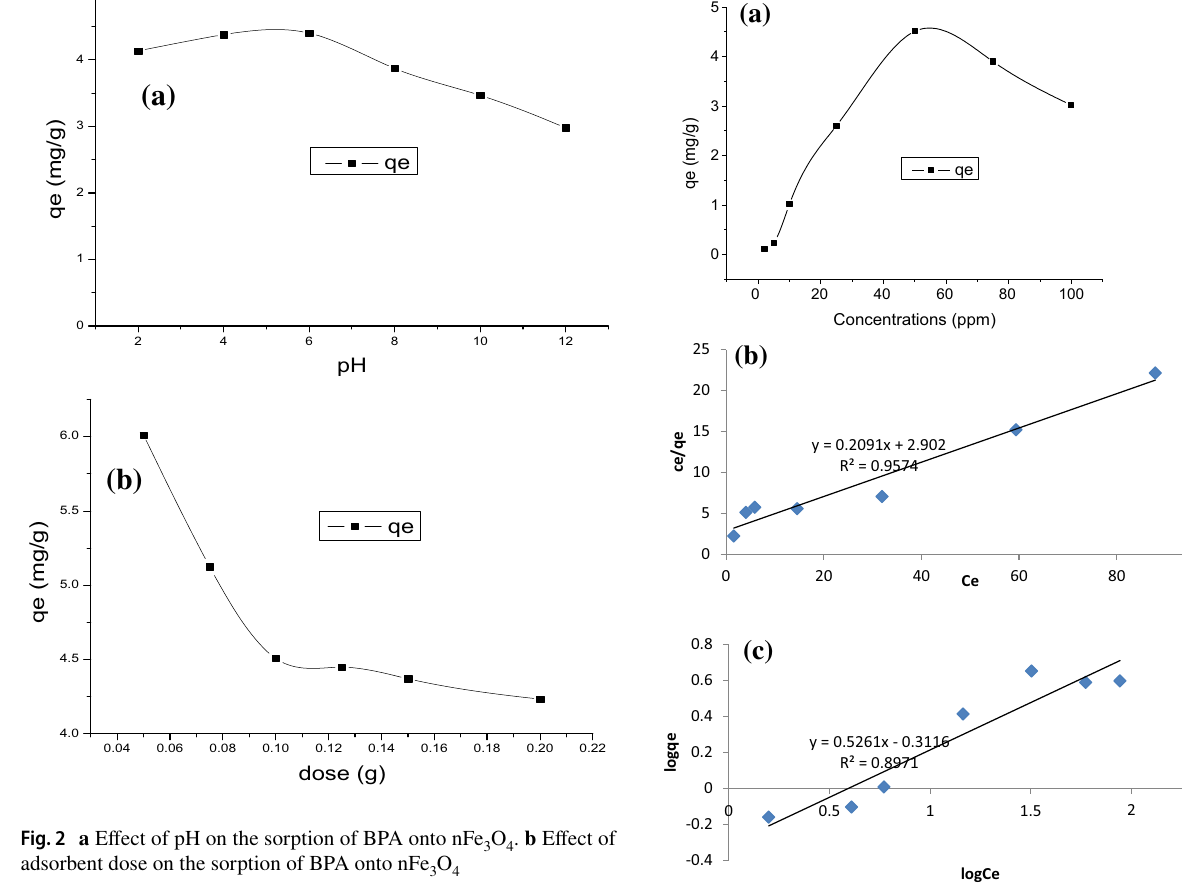
3 O 4 . b Effect of